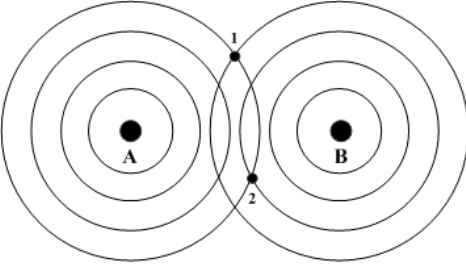
Figure 1. Data field property sketch-map.